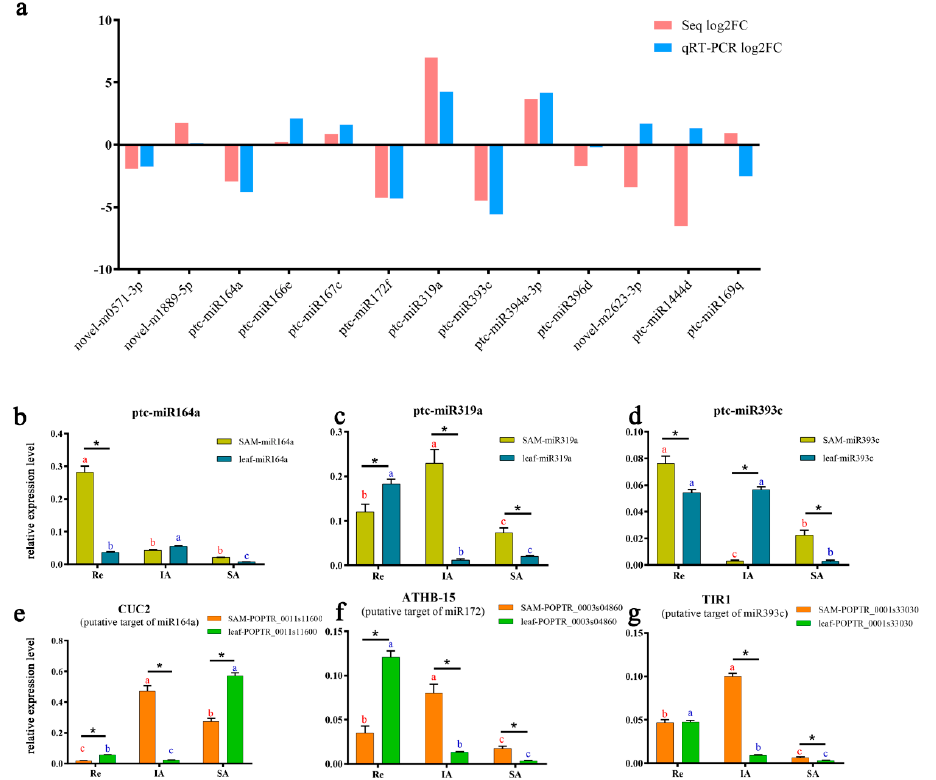
Figure 7. Confirmation of the expression of miRNAs derived from high-throughput sequencing. ( a ) The expression ratios [log 2 (SAM/leaf)] of miRNAs, as determined by deep sequencing (pink bars) and qRT-PCR (blue bars). ( b – g ) The relative expression levels of ptc-miR164a ( b ), ptc-miR319a ( c ), ptc-miR393c ( d ), CUC2 ( e ), ATHB15 ( f ), and TIR1 ( g ) at three development stages, as determined by qRT-PCR. The columns and error bars indicate the means and standard deviations ( n = 3), respectively; * indicates significant differences ( p < 0.05) between the shoot apical meristem (SAM) and leaves at each stage; Non-overlapping letters (a–c) indicate significant differences ( p < 0.05) of SAM (red letters: a, b, c) or leaves (blue letters: a, b, c) among three different